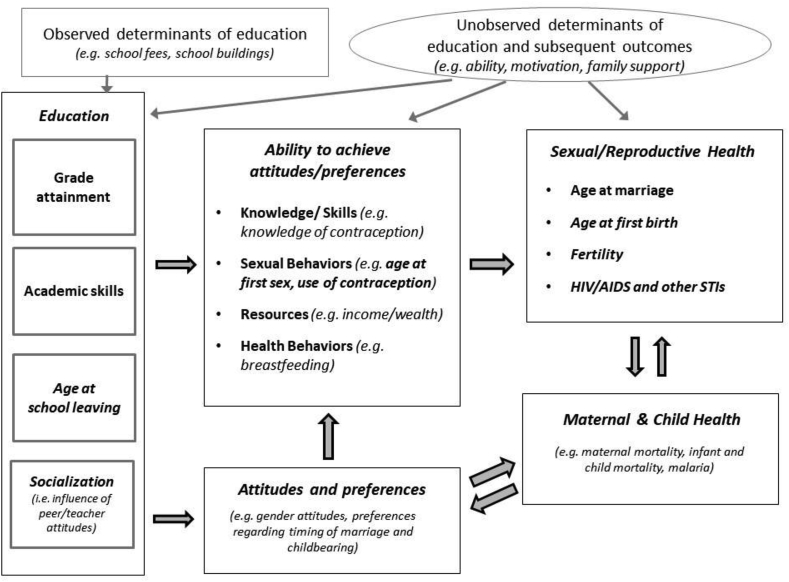
Conceptual framework showing hypothesized mechanisms linking education and sexual and reproductive health.